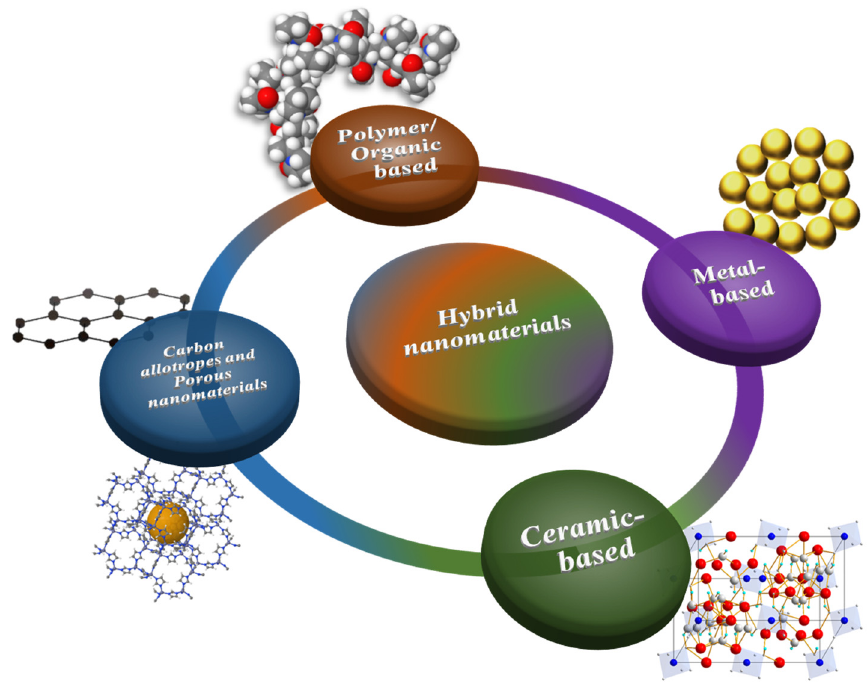
Figure 3. Schematic illustration of the different groups of additives used to modify polymeric membranes by blending.